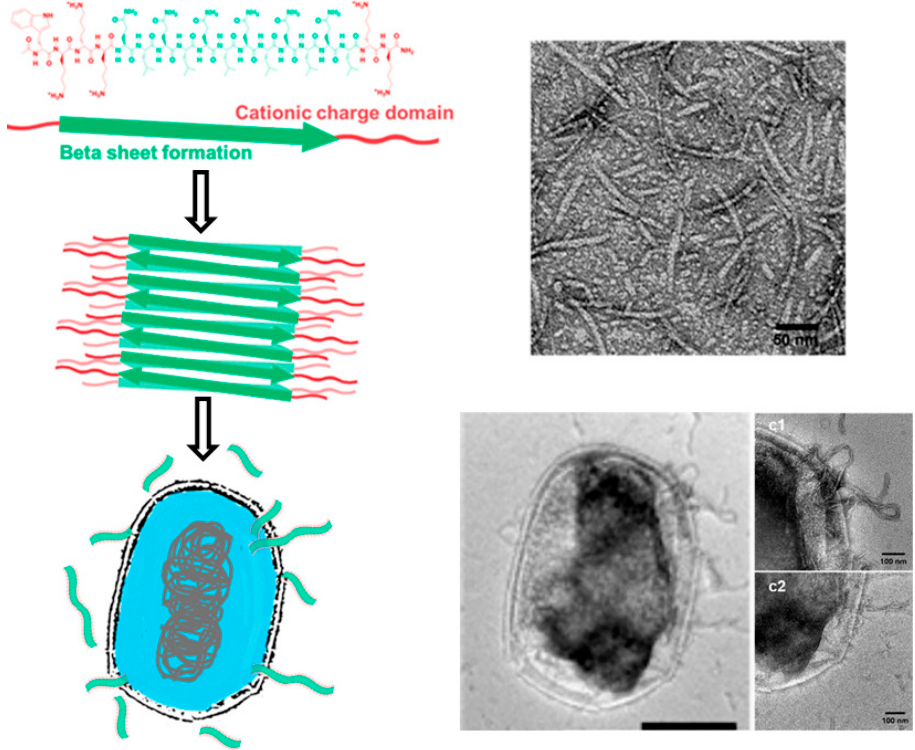
Figure 3. (Left) MDP D-W362 self-assembly into SAANs to form β -amyloid nanofibers. (Top right) Negatively stained TEM of D-W362 forming β -amyloid nanofibers and (bottom right) TEM of E. coli treated with D-W362 (c1 and c2) zoomed into bacterial membrane. Adapted with permission from [86]. Copyright 2018 American Chemical Society.